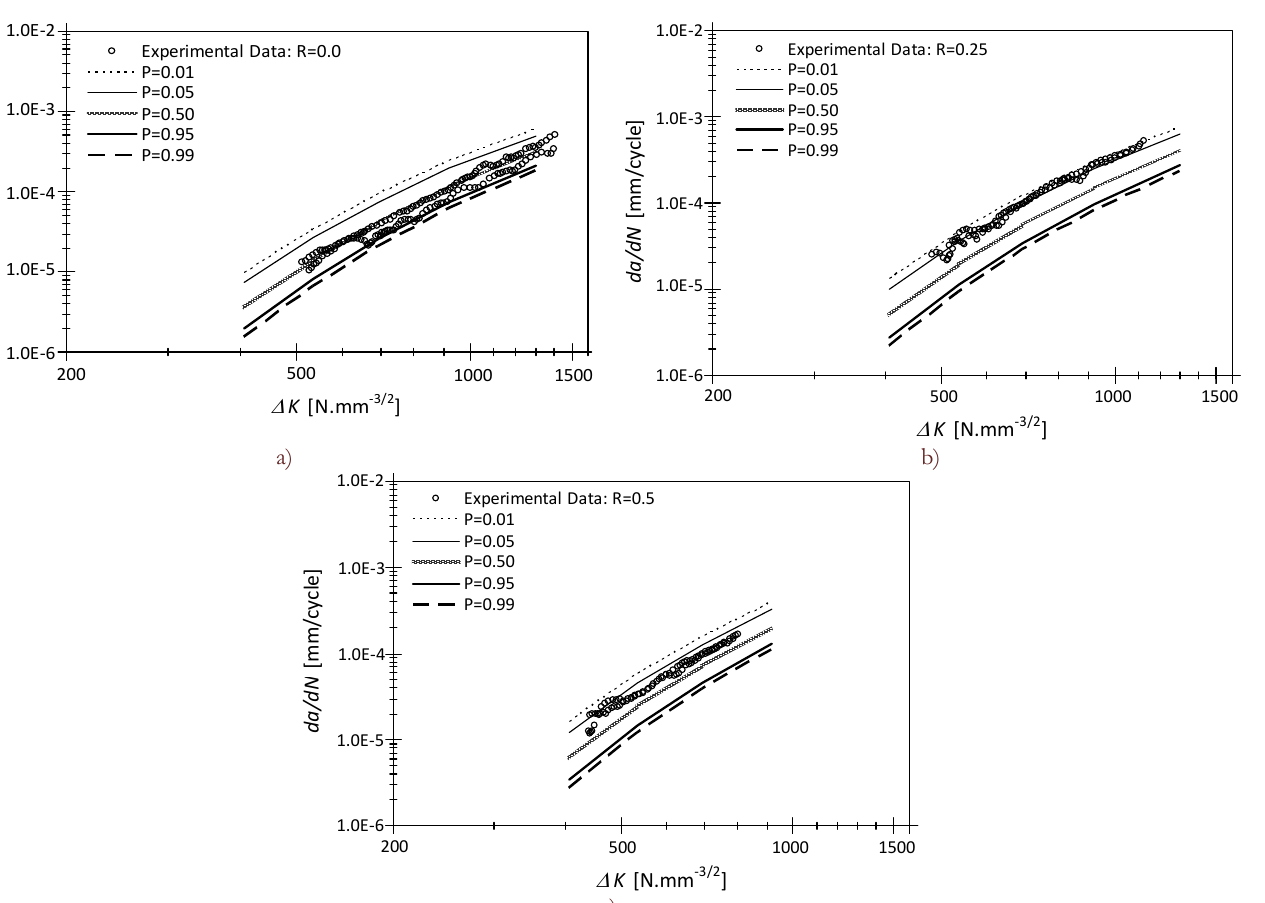
Figure 16: Probabilistic prediction of the fatigue crack propagation based the p- ε -N field, for the S355 steel: a) R R σ